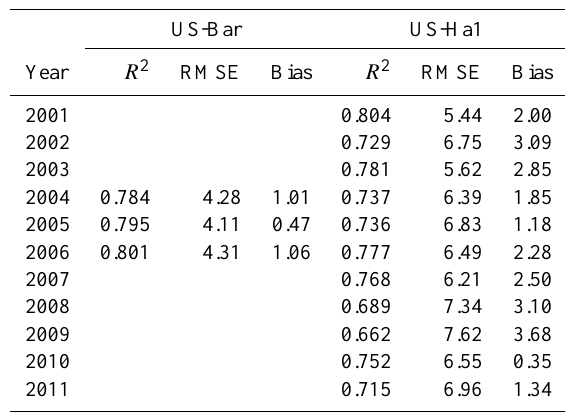
Table 3. The model performance at two study sites as evalu- ated using hourly data. Units for RMSE and mean bias error (Bias) are in micromoles of CO 2 per square meter per